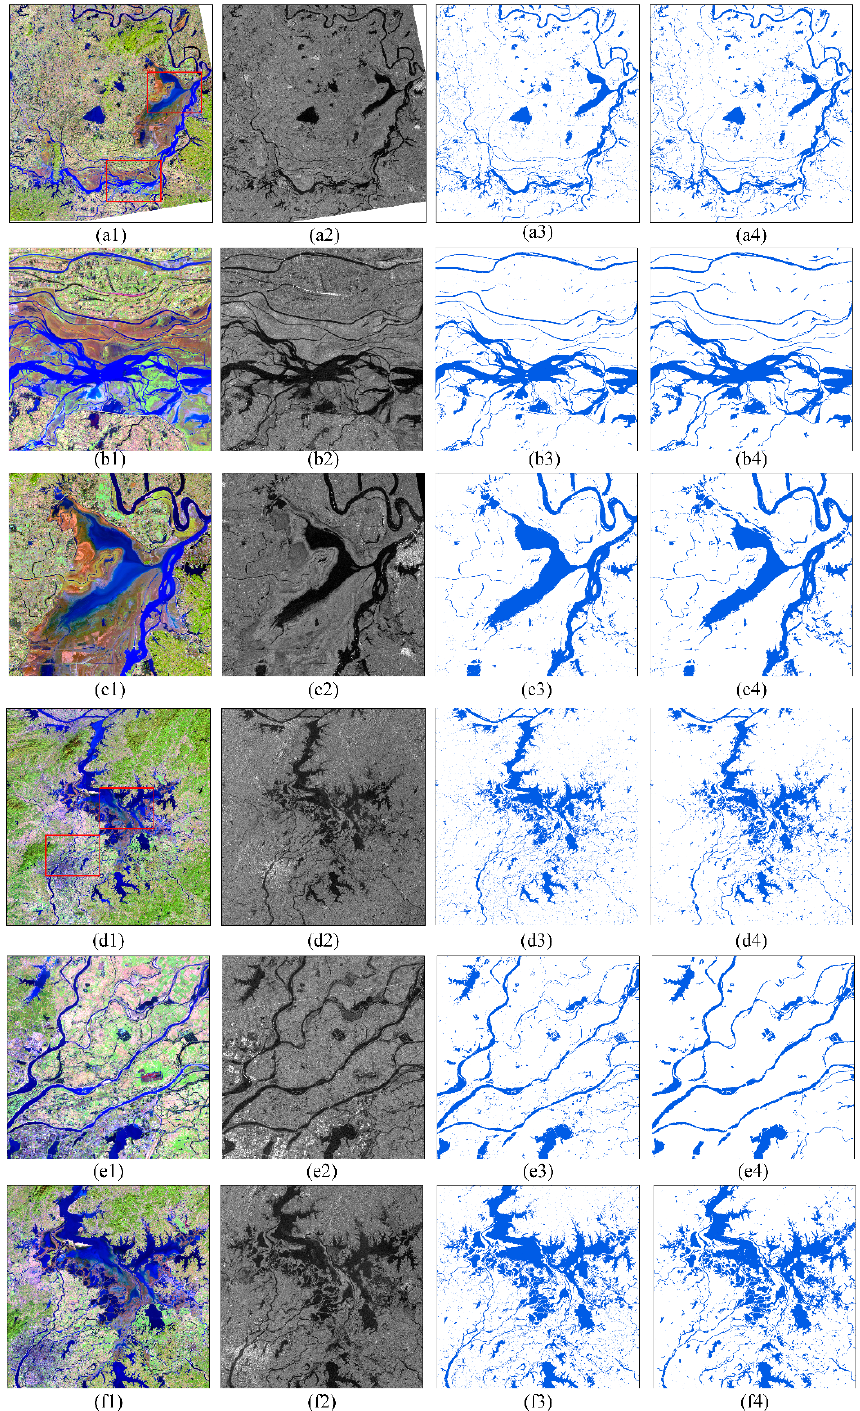
Figure 7. Comparison of water extraction results based on Sentinel-2 optical data and Sentinel-1 SAR data. ( a1 – f1 ) show the Sentinel-2 images; ( a2 – f2 ) show the Sentinel-1 images; ( a3 – f3 ) present extraction results from the Sentinel-2 images; and ( a4 – f4 ) present extraction results from Sentinel-1 images.